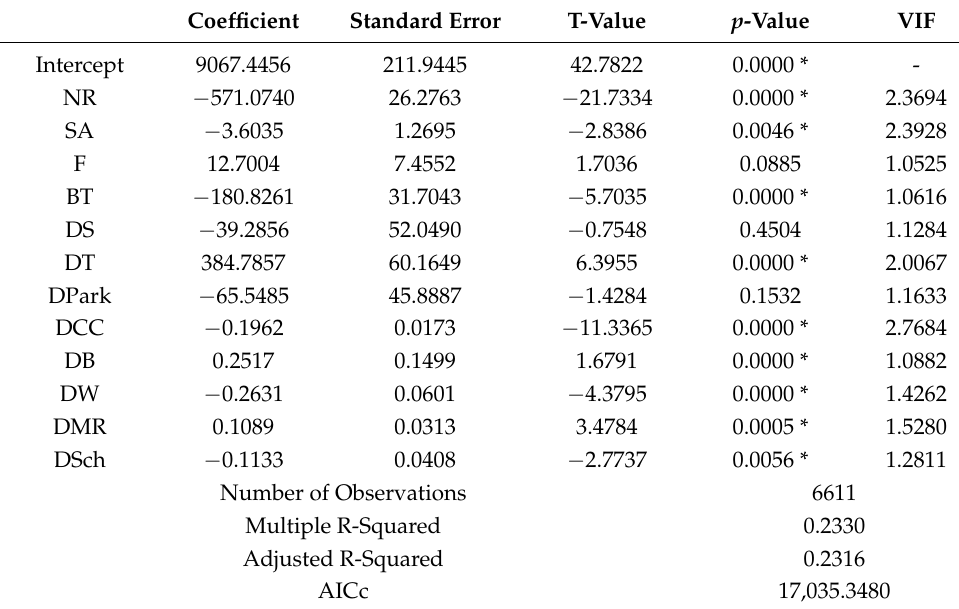
Table 4. Summary of ordinary least squares (OLS) regression